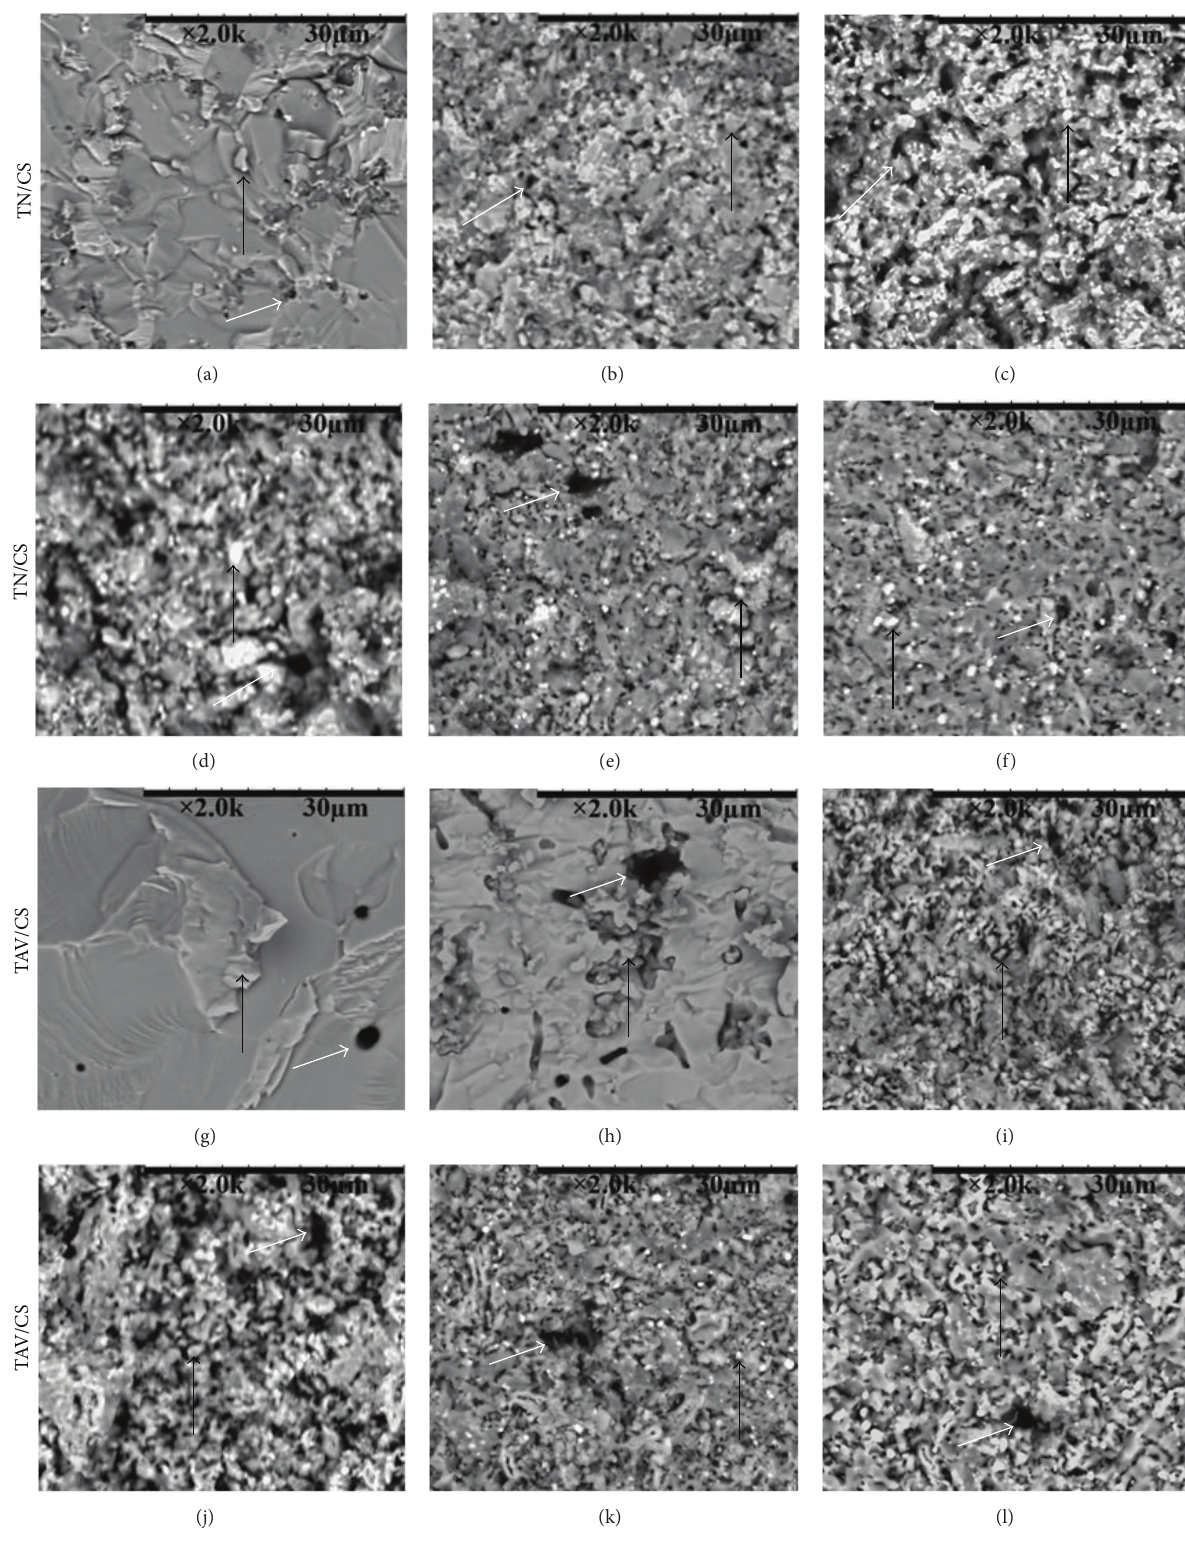
Figure 10: Scanning electron microscope (SEM) on fractured surface of the cermets TN/CS (top) and TAV/CS (down) with CS content (wt %) of (a and g) 0, (b and h) 10, (c and i) 30, (d and j) 50, (e and k) 80, and (f and l) 90. All the bars are 30 𝜇 m; all black coloured arrows indicate the second phase particles and all white coloured arrows imply the pores at the fracture